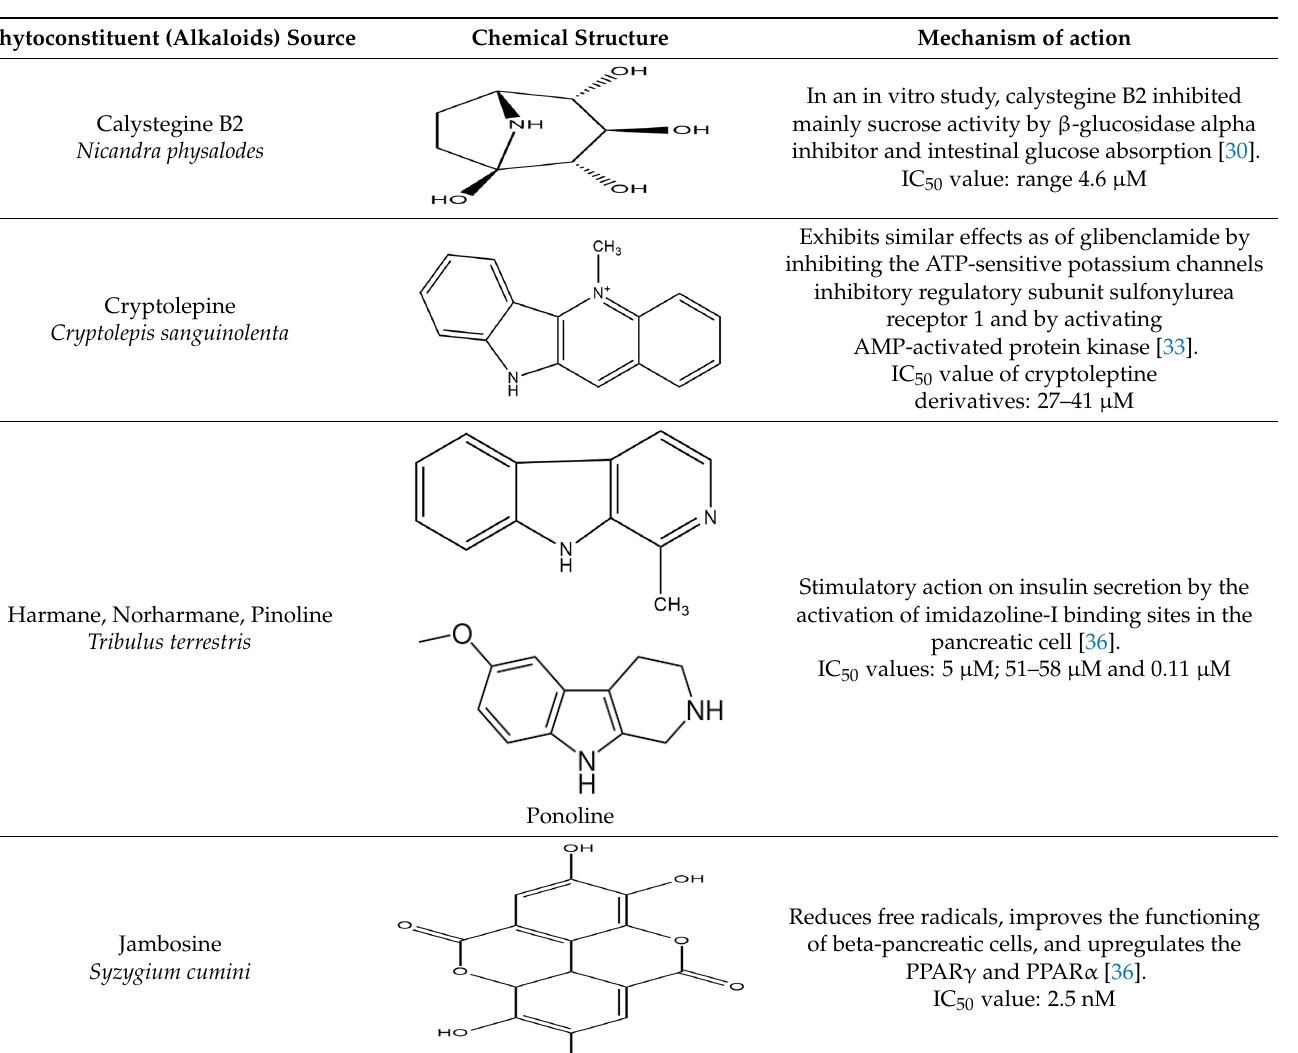
Reduces free radicals, improves the functioning of beta-pancreatic cells, and upregulates the PPAR γ and PPAR α [36].